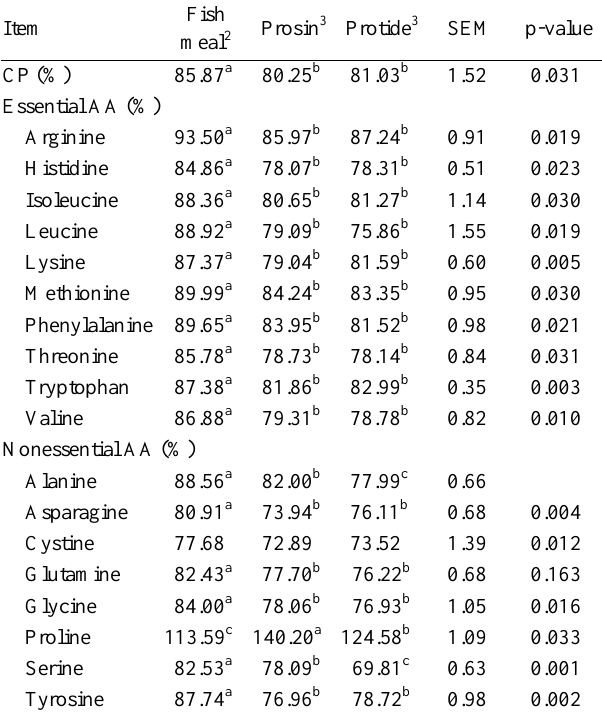
Table 6. SID of CP and AA in fish meal and single-cell proteins (Prosin and Protide), Exp.2